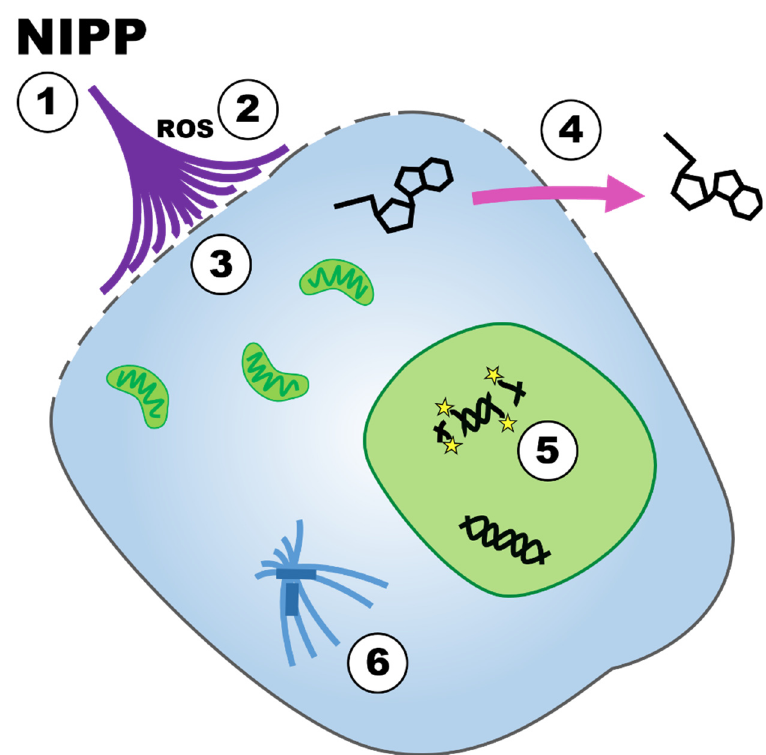
Figure 9. Model for the devitalizing NIPP efficacy on tumor cells. NIPP treatment of tumor cells (1) leads to the formation of ROS (2), which interfere with the cytoplasmic membrane and increase its permeability (3). Subsequently, the loss of ATP leads to the impairment of cellular metabolism (4), which induces apoptosis in part of the cell population (5) and reduces the growth of the entire cell population (6).